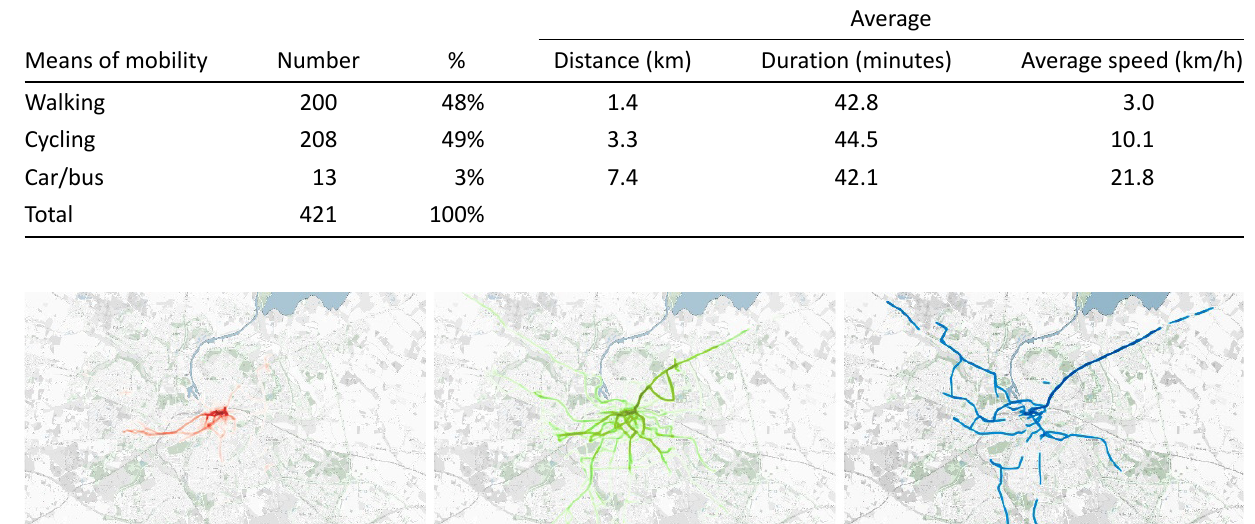
Table 2. Respondents’ movements during weeks 8, 9, and 17 of 2017.